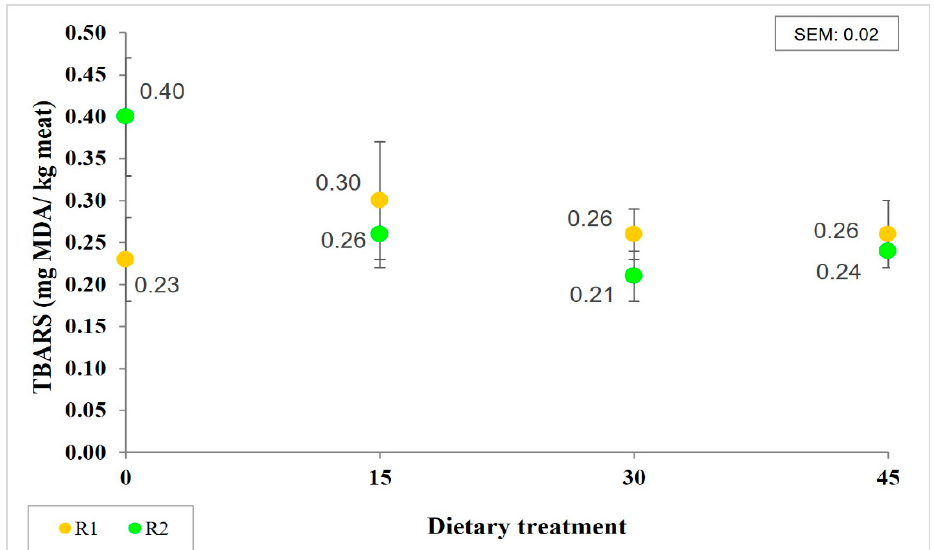
Figure 2. Lipid oxidation (mean ± SEM) measured as thiobarbituric acid reactive substances (TBARS) in LTL at the end of storage and retail display conditions for each dietary treatment (0, 0%DG control; 15, 15% DG; 30, 30%DG; 45, 45% DG, DM basis).